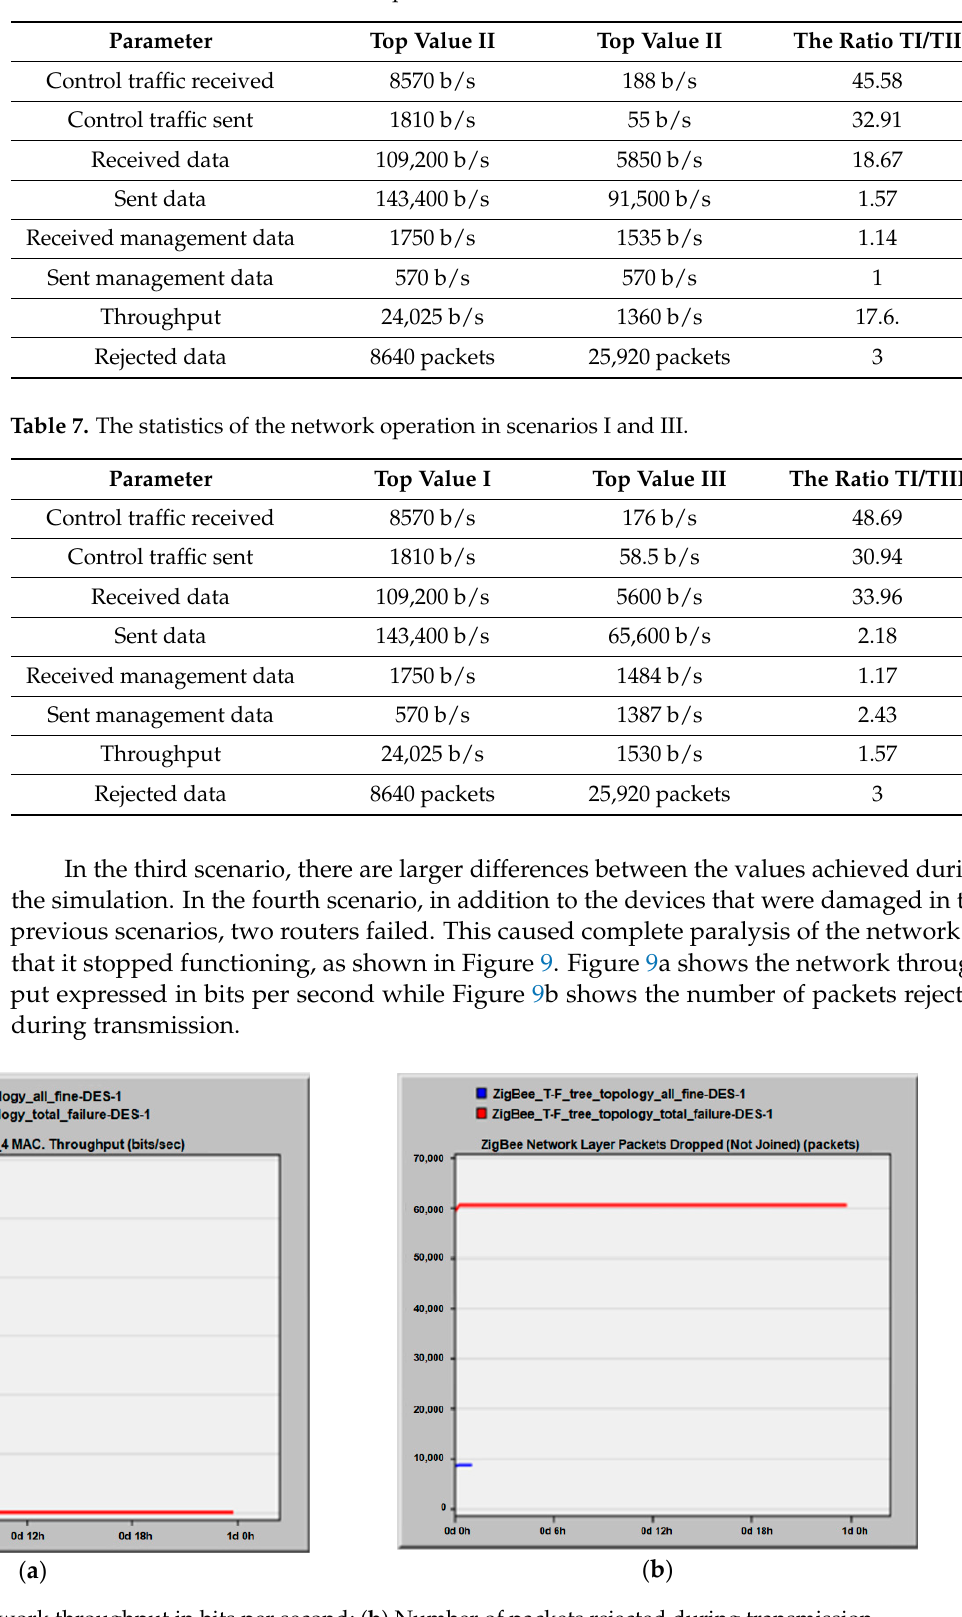
Table 6. The statistics of the network operation in scenarios I and II.